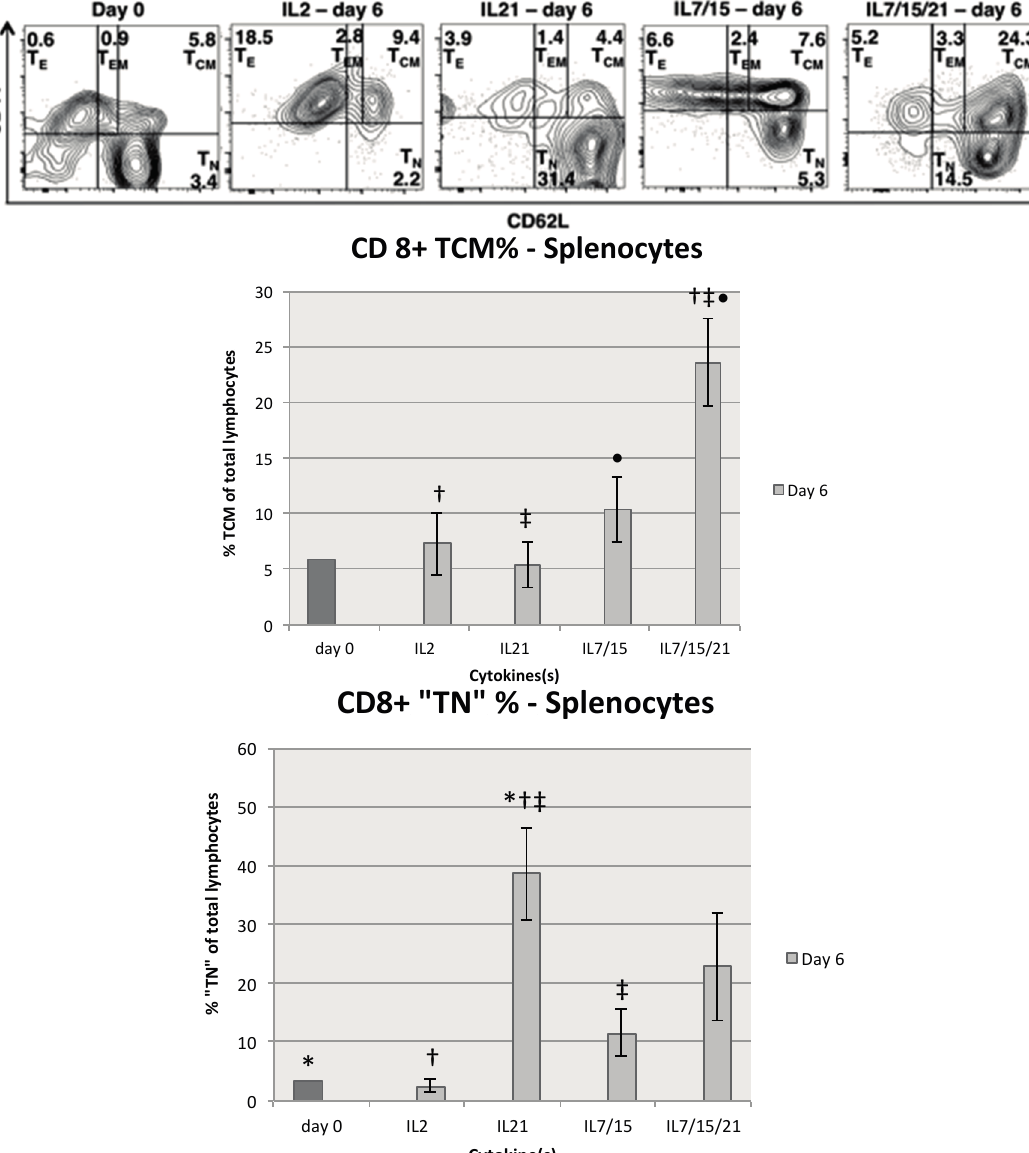
Figure 3. On day 0 and six days after B/I activation and culture in IL-2, IL-21, IL-7/15 or IL-7/15/21, splenocytes were stained for CD4, CD8, CD44 and CD62L and analyzed by flow cytometry to determine the percentages of T cell subsets: CD44+CD62L − T effector (T E ), CD44+CD62Llow T effector memory (T EM ), CD44+CD62Lhigh T central memory (T CM ) and CD44 − CD62L+ “T naïve” (“T N ”) cells ( a ); Cells were FSC/SSC gated on viable lymphocytes and CD8+ T cells and percentages of T cell subsets (in black) were determined. Results are from a representative experiment out of five independent experiments with similar results. Average percentage of T CM , † ( vs . IL2) = p = 0.04, ‡ ( vs . IL21) = p < 0.003, • ( vs . IL7/15) = p = 0.056 ( b ) or T N , * ( vs . day 0) = p < 0.016, † ( vs . IL2) = p = 0.0014, ‡ ( vs . IL7/15) = p < 0.029 ( c ) for cells expanded from splenocytes in five experiments before and after B/I activation and culture for six days in IL-2, IL-21, IL-7/15 or